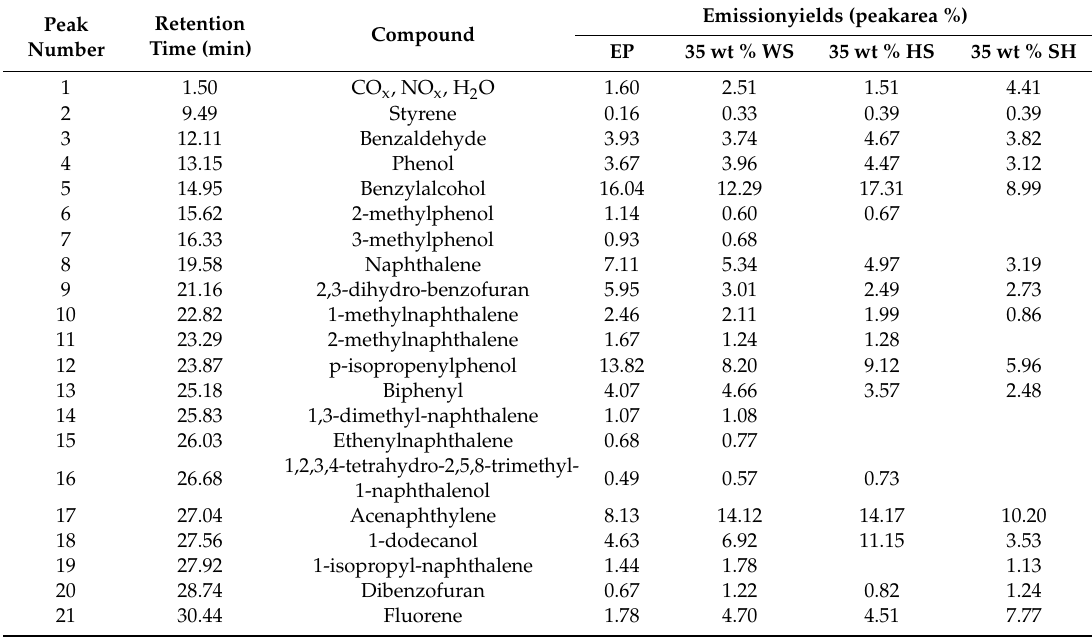
Table 4. Thermal degradation products of selected modified epoxy composites at 650 ◦